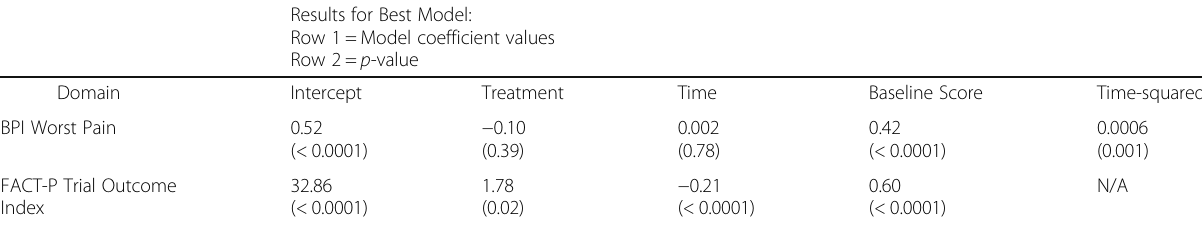
Table 2 Best Model Results for BPI Worst Pain and FACT-P Trial Outcome Index Results for Best Model: Row 1 = Model coefficient